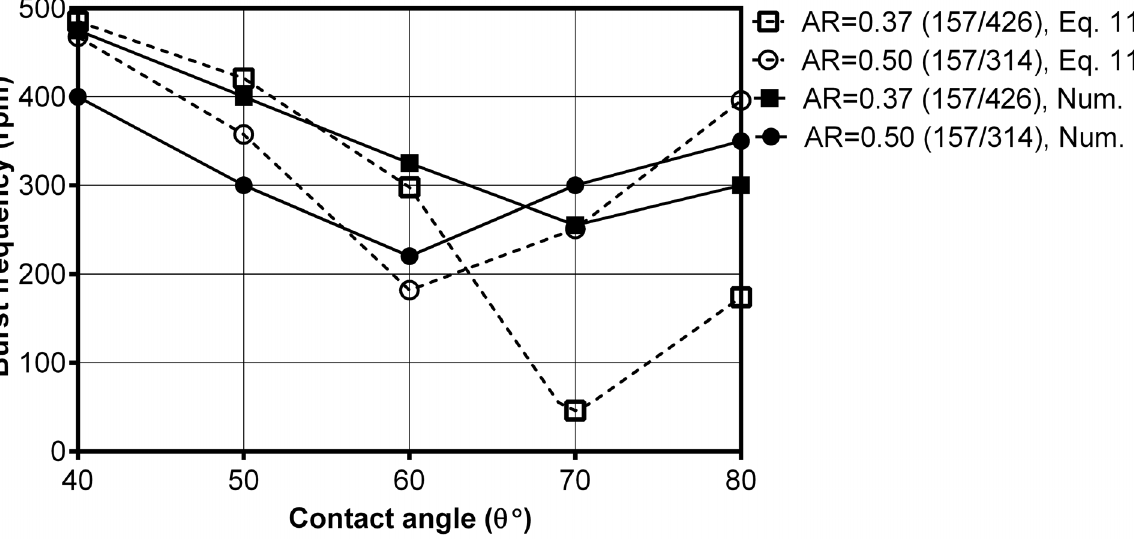
Figure 9. The distribution of the burst frequencies from the CFD model and Eq. 11 [ 25 ] with respect to different aspect ratios and contact angles for Cases 27–42.